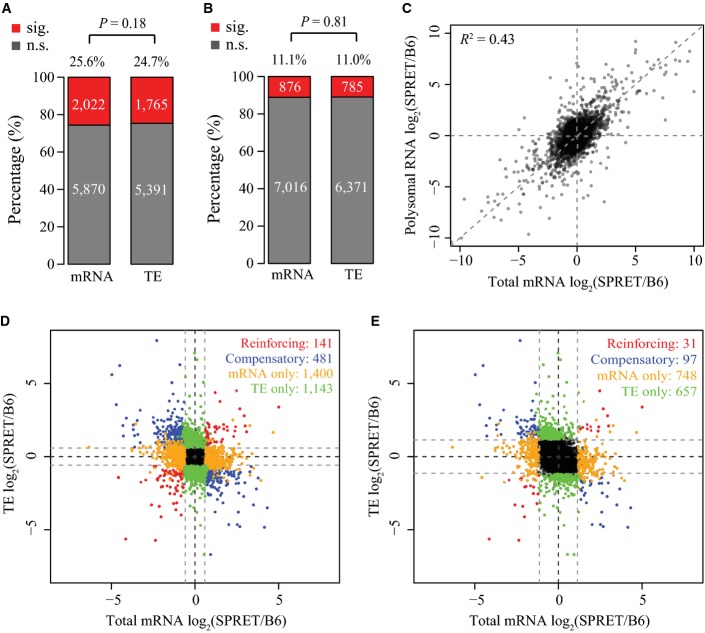
Allelic regulation at both transcriptional and translational levels with different significance cut-offs.A, B Panels are the same as Fig4A, but with allelic fold change cut-off = 1.5 (A) or 2.2 (B).
C Scatterplot comparing the log2-transformed allelic ratio of cellular mRNA abundance (x-axis) versus that of polysome-associated mRNA abundance (y-axis). Each dot represents one gene. The R2 of 0.43 indicates that less than half of allelic divergence in polysome-associated RNA abundance could be explained by the allelic divergence in mRNA cellular abundance.
D, E Panels are the same as Fig4B, but with allelic fold change cut-off = 1.5 (D) or 2.2 (E).